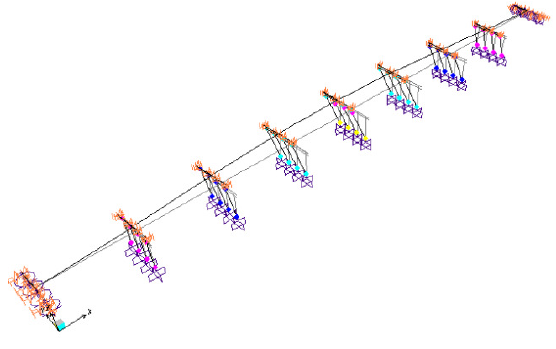
Fig. 11. Plastic hinge formation in the last transverse pushover step